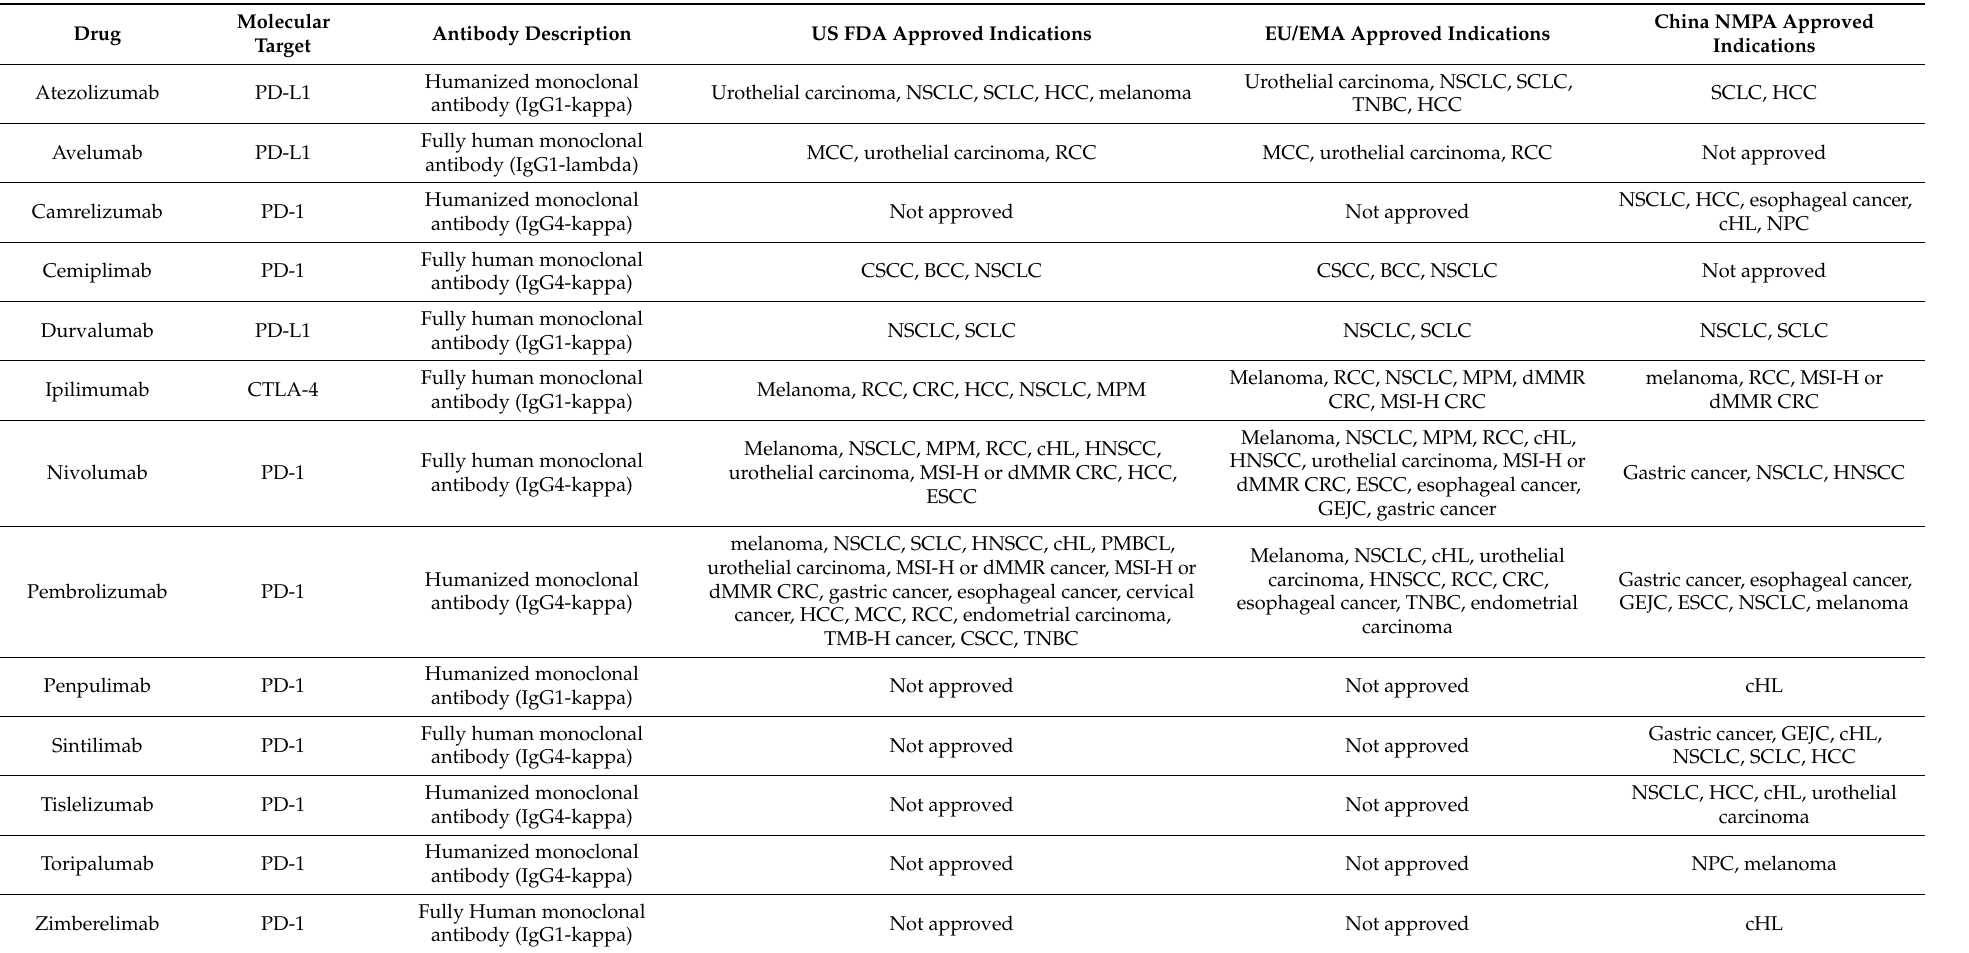
Table 1. Immune checkpoint inhibitors approved for human